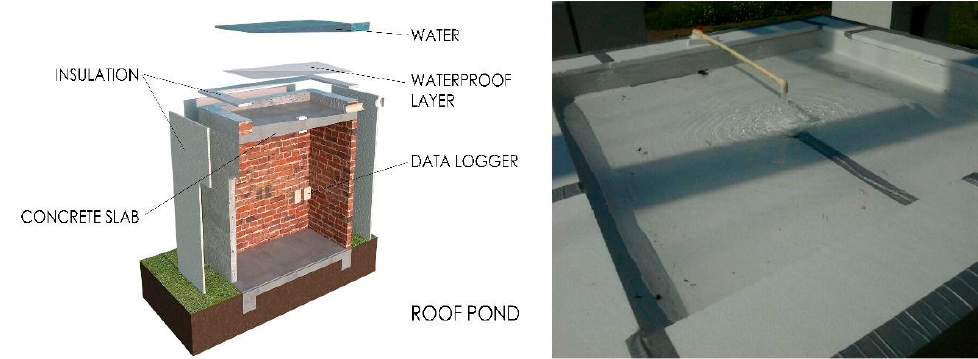
Figure 6. Cross section diagram of the roof pond cell with its elements.